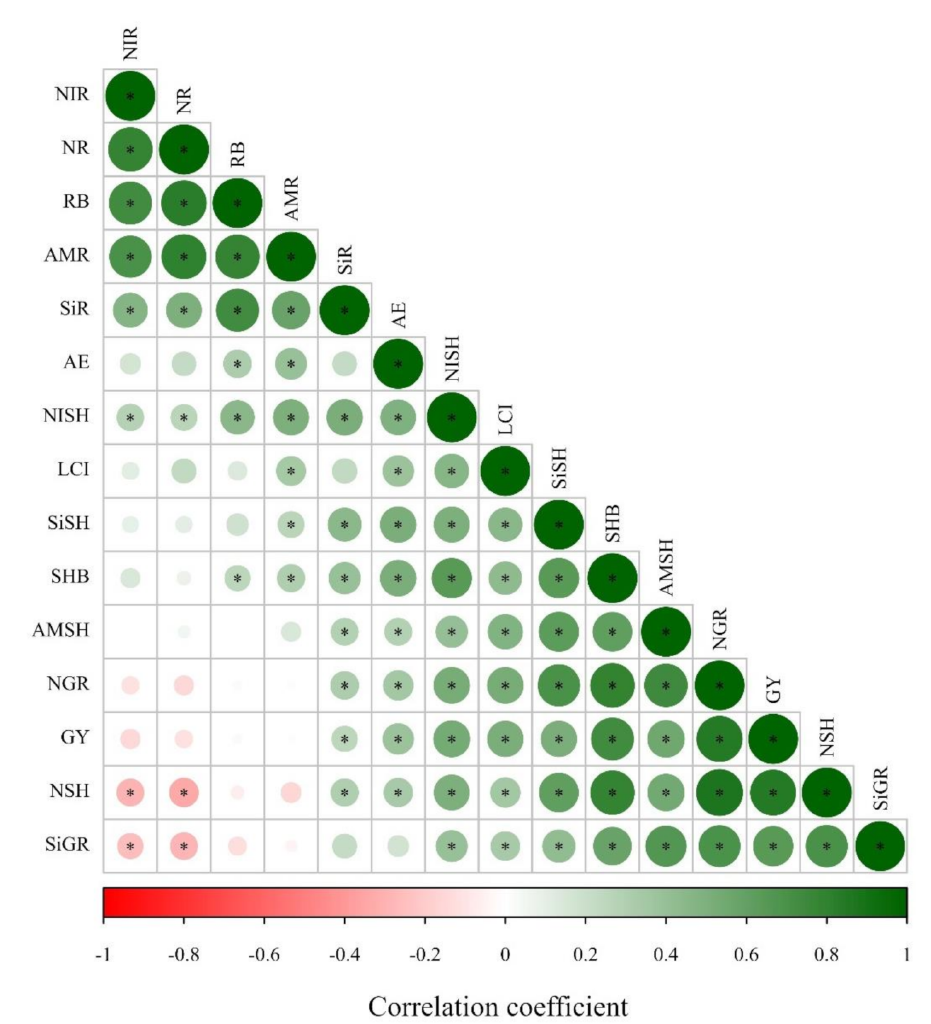
Figure 2. Heatmap showing the Pearson’s correlation among the analyzed parameters in maize plants in response to Si application and N levels. * indicates significant relationship ( p ≤ 0.05). Abbreviation: NIR = N-NO 3 − accumulation in root, NR = total N accumulation in root, RB = root biomass, AMR = N-NH 4+ accumulation in root, SiR = Si accumulation in root, AE = agronomic efficiency, NISH = N-NO 3 − accumulation in shoot, LCI = leaf chlorophyll index, SiSH = Si accumulation in shoot, SHB = shoot biomass, AMSH = N-NH 4 + accumulation in shoot, NGR = total N accumulation in grain, GY = grain yield, NSH = total N accumulation in shoot, SiGR = Si accumulation in